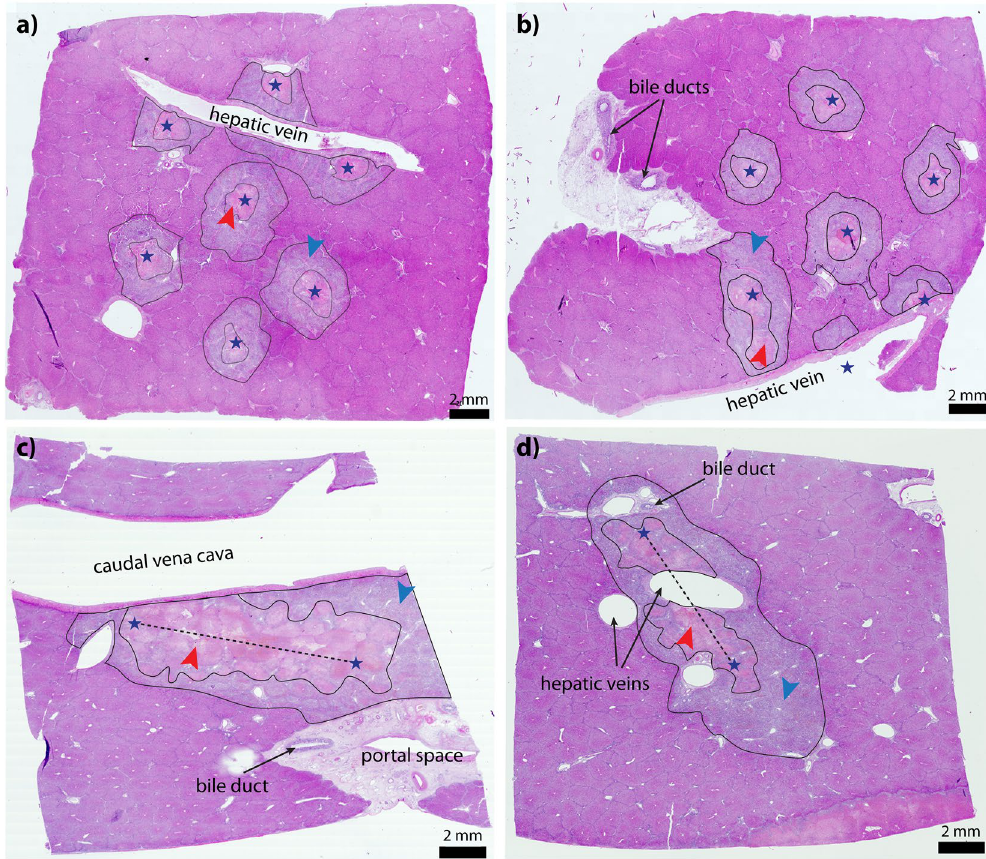
Figure 4. Microscopic images of treated liver 2 days post ECT. Electrode insertion sites are denoted with stars and dashed lines. Portal spaces and major hepatic vessels are contained in the treatment zone. Zones A (red arrowhead) and B (blue arrowhead) are outlined in black. ( a , b ) Samples S1 and S2 of animal 1, treated with hexagonal geometry electrodes. ( c , d ) Samples S3 and S4 of animal 2, treated with linear geometry